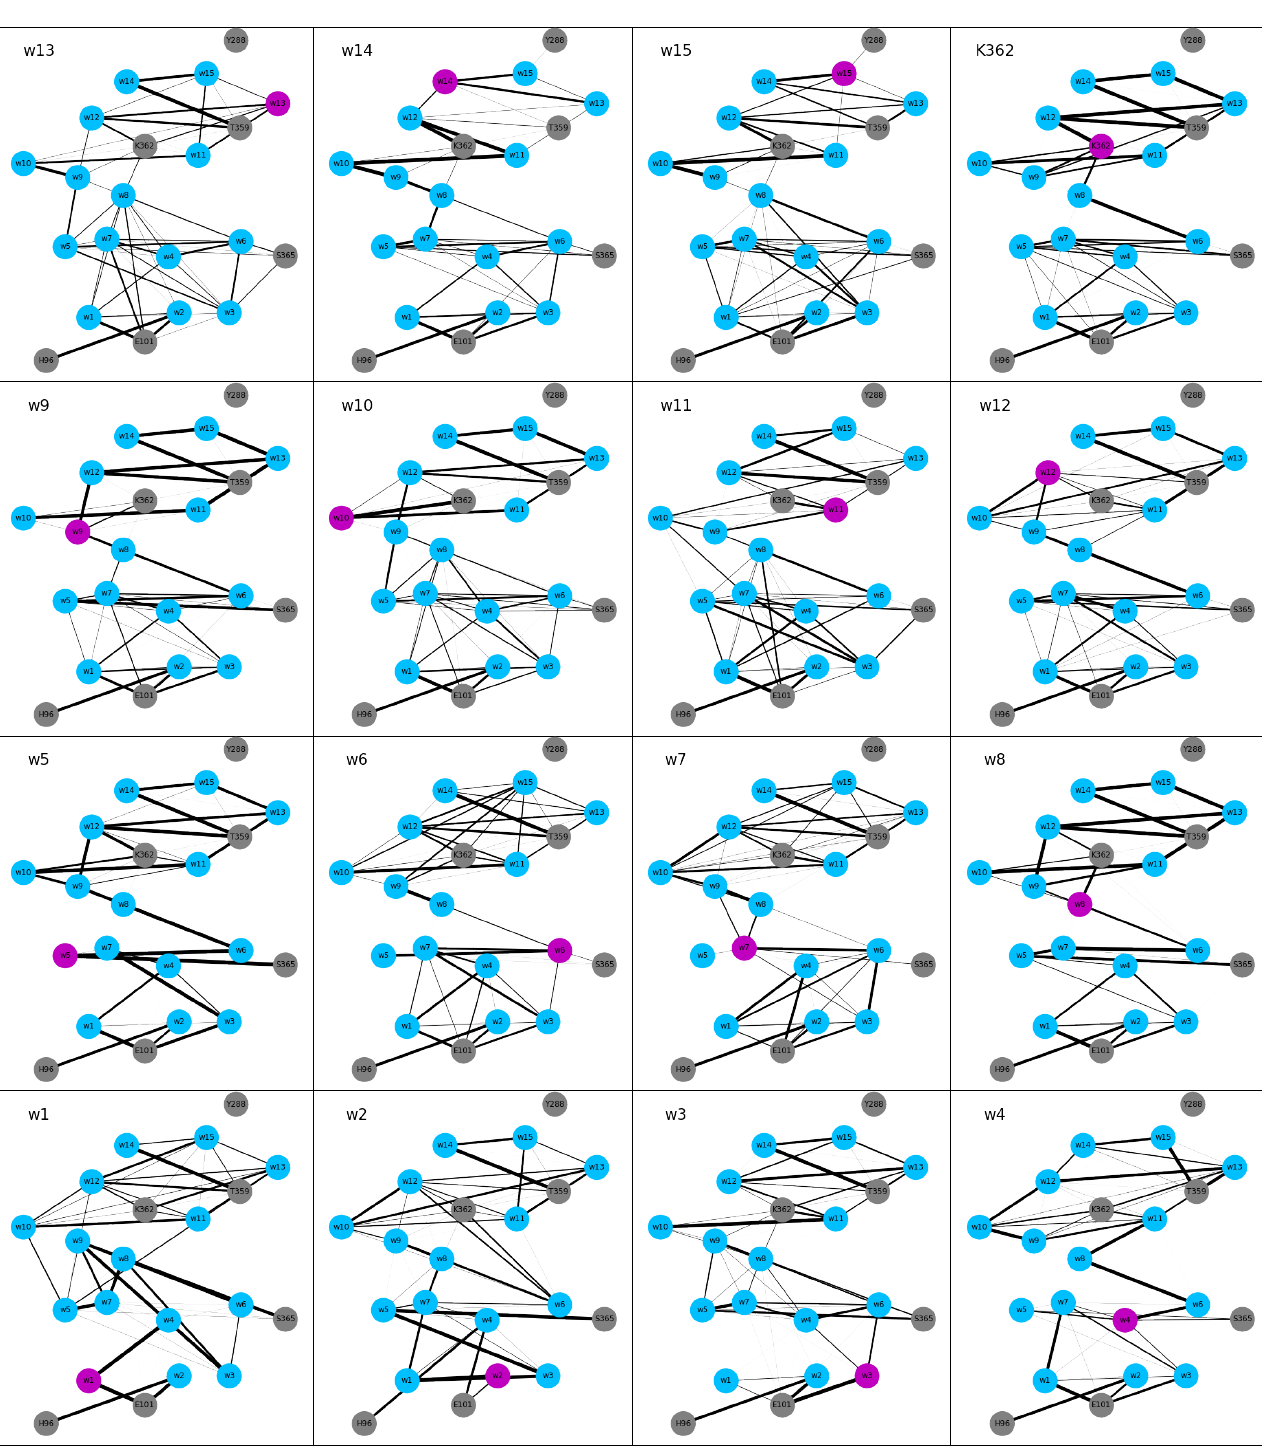
Figure 6. Undirected hydrogen-bonded network computed from the MD simulations with the excess proton located at different residues, based on a snapshot with K362 in “down” position. The nodes of the network are the protein residues (in gray) Y288, T359, K362, S365, H96, or E101, and the fifteen water molecules (in blue) in the channel. The residue carrying the excess proton is highlighted in magenta. Edges of the network correspond to hydrogen bonds and are shown as lines. The thickness of the lines indicate the probability of the hydrogen bonds. Hydrogen-bonded networks of models with protonated H96 and E101, respectively, are shown in Supplementary Figure